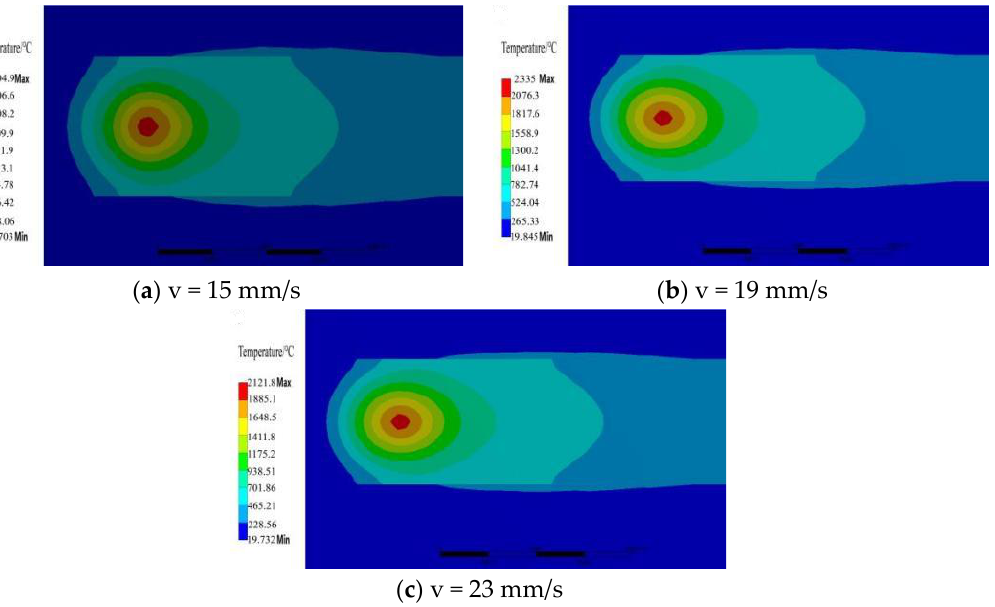
Figure 5. Cloud map of temperature field distribution under different scanning speeds. Through numerical simulation, it is found that the scanning speed in the range of 15 – 23 mm/s can form a better molten pool morphology. Figure 6 shows the thermal cycle curves of the center of the molten pool at different scanning speeds. The thermal cycle curves have a similar change process, but the peak time is different. This is because the higher the scanning speed, the shorter the time to form the cladding layer of the same length. The scan speed just changes the energy absorbed by the substrate and powder per unit time.